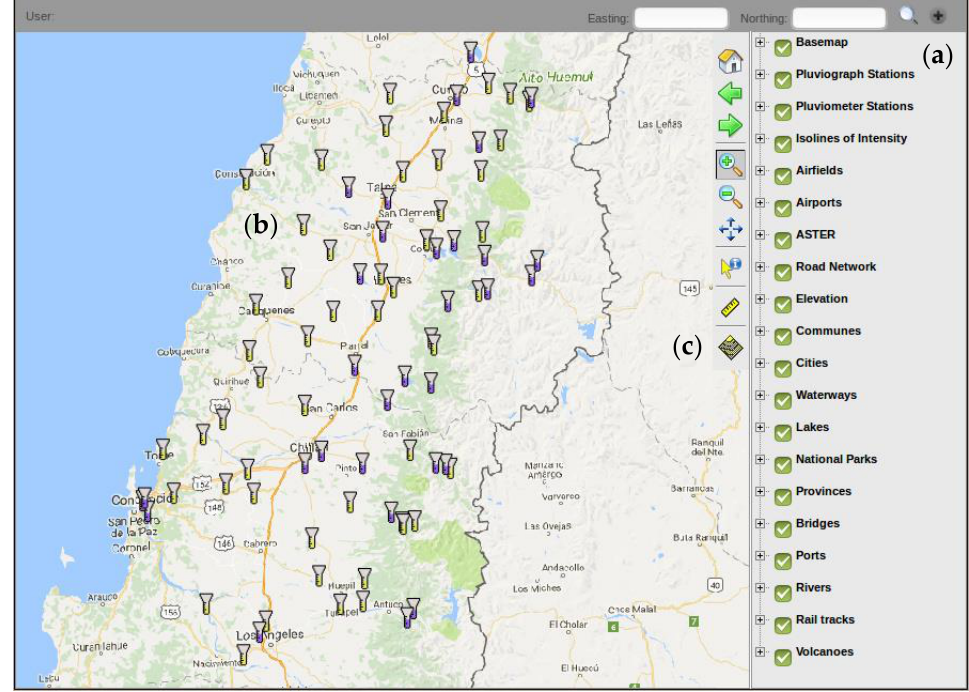
Figure 4. Graphical user’s interface of WEBSE IDF . ( a ) Drop-down menu; ( b ) georeferenced pluviograph and pluviometric gauges; and ( c ) toolbar menu.